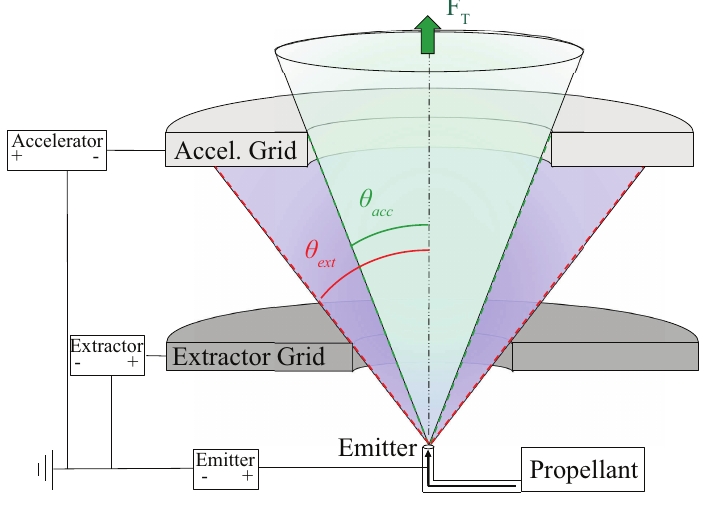
Figure 1. Electrospray emitter and electrode geometry with line-of-sight